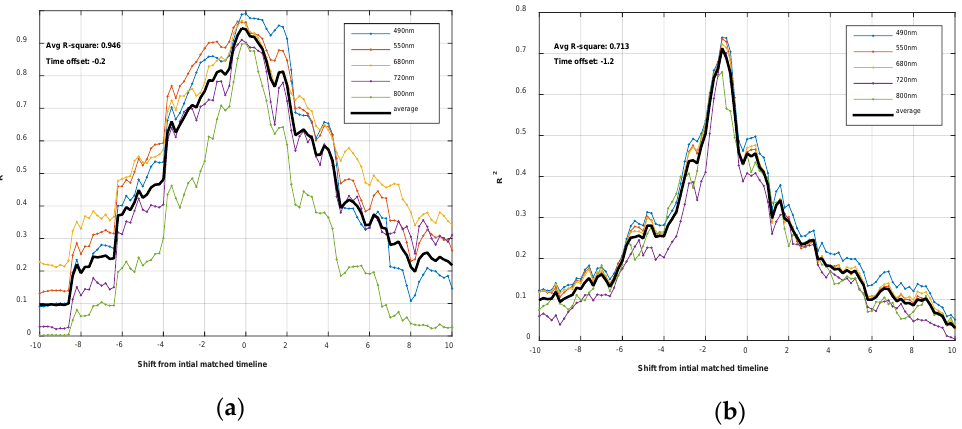
Figure 4. Linear correlation between sample pairs of multispectral camera intensity and spectrometer reflectance at Site 1 ( a ) and Site 2 ( b ). Each subfigure includes five curves representing the five multispectral bands, plus a thicker line representing the average R 2 . Each curve is the correlation for the given band at 0.2 s interval time offsets over the ±10 s range. The maximum average R 2 and its corresponding time offset are given in the upper left of each graph.